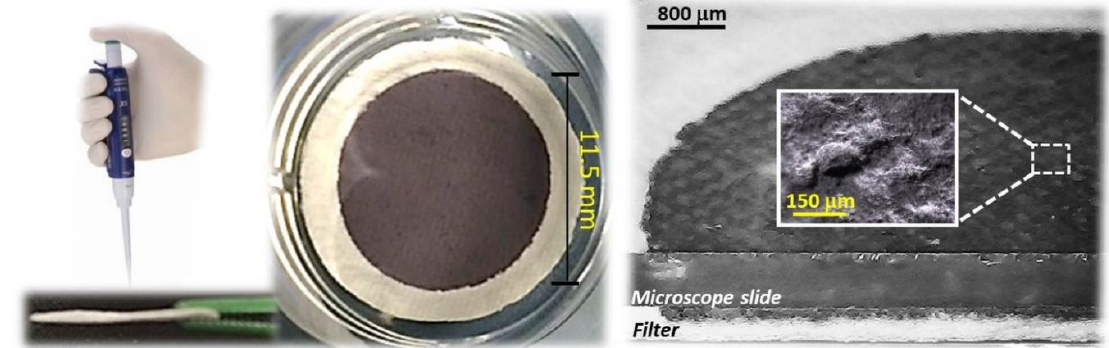
Figure 5. ( Left ) Drop deposition of TiO 2 /AuNPs aqueous suspension; top view ( middle ) and side view ( right ) of the resulting disc. The inset depicts an optical magnification of the film surface.